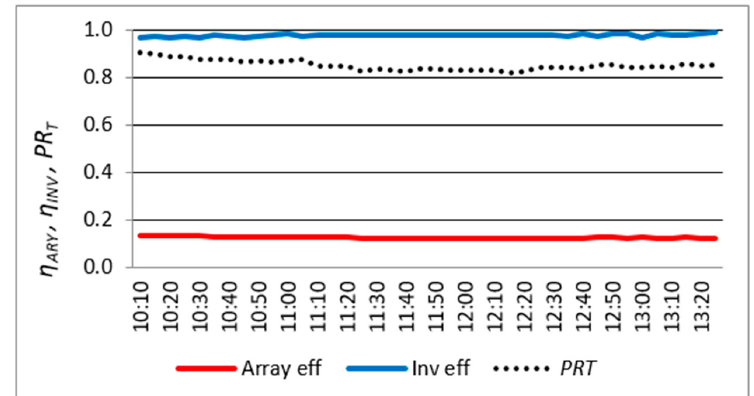
Figure 9. Change of the PR T , the inverter and PV array efficiency during inverter saturation.